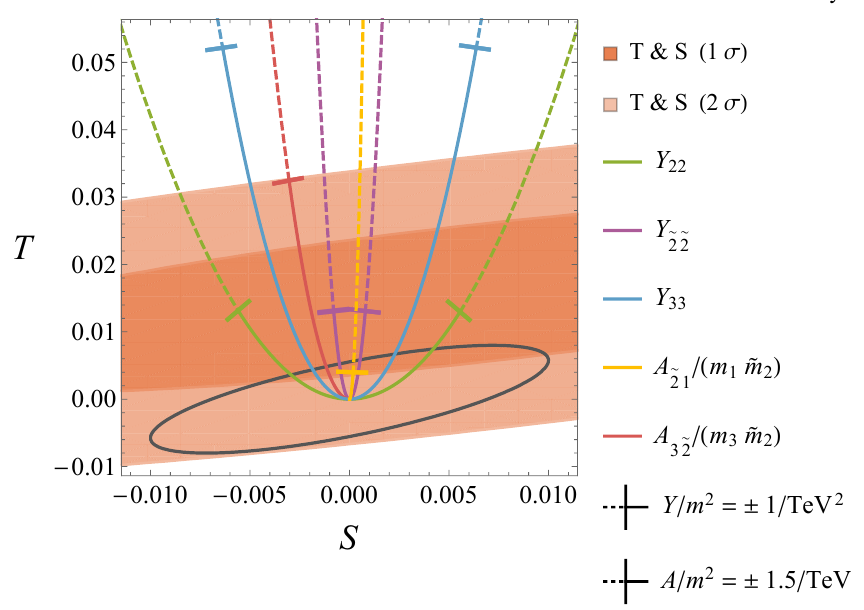
Figure 4. Correlations between S and T for four different Lagrangian parameters in eq. (2.4), assuming that only one of them is non-zero at a time. For simplicity, we assumed all LQ masses to be equal. While Y 22 and Y ˜2˜2 can yield both positive and negative effects in S , the effect in the T parameter is positive definite. Since our prediction for S and T depends on a single combination of parameters ( Y/m 2 or A 2 /m 4 ), we used one degree of freedom to obtain the preferred region in the S - T plane, such that the region within the ellipse labelled by 1 σ ( 2 σ ) corresponds to 68% C.L. ( 95%